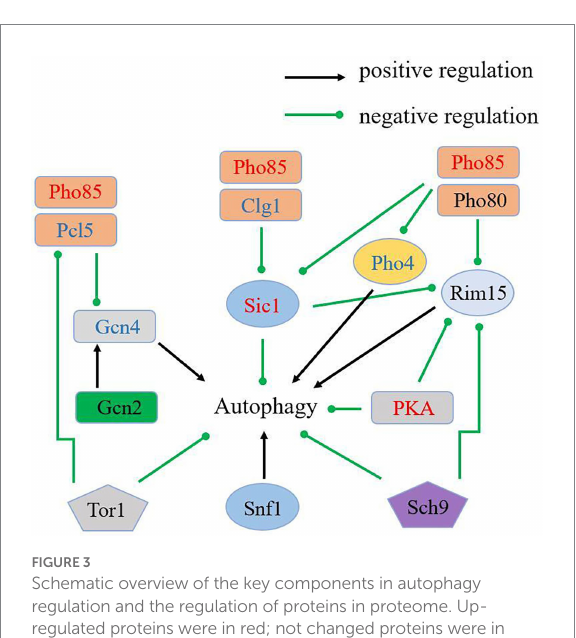
FIGURE 3 Schematic overview of the key components in autophagy regulation and the regulation of proteins in proteome. Up- regulated proteins were in red; not changed proteins were in black; not detected proteins were in